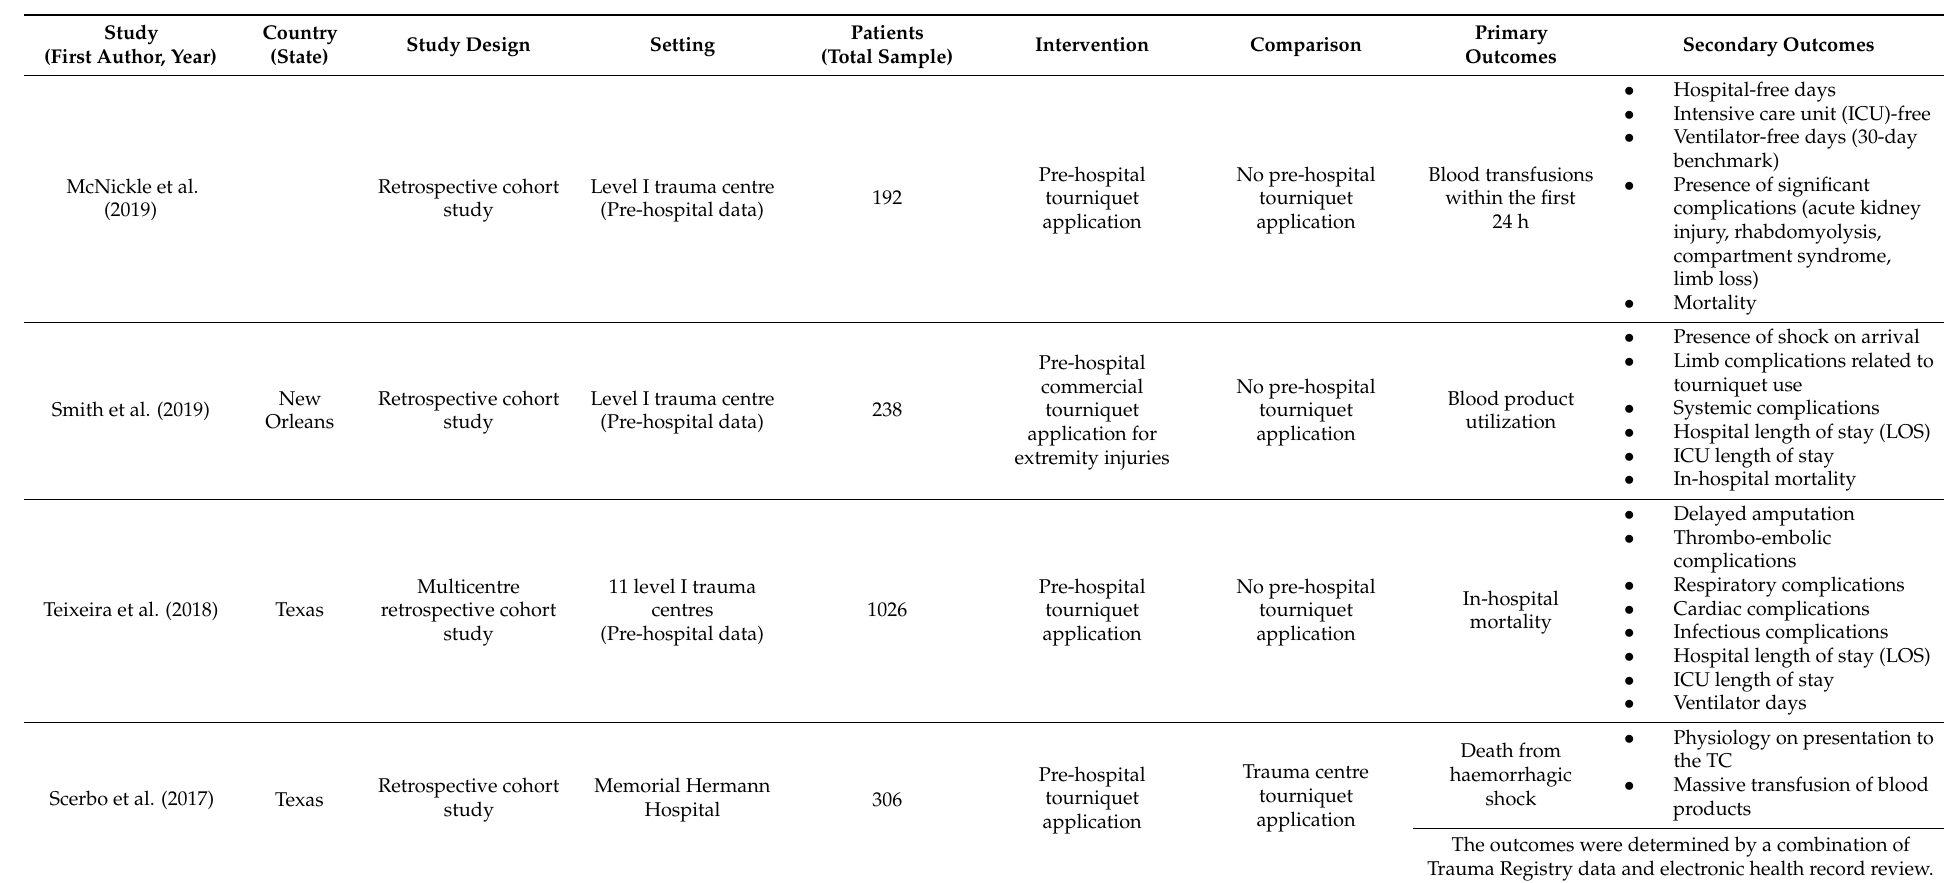
Table 1. General